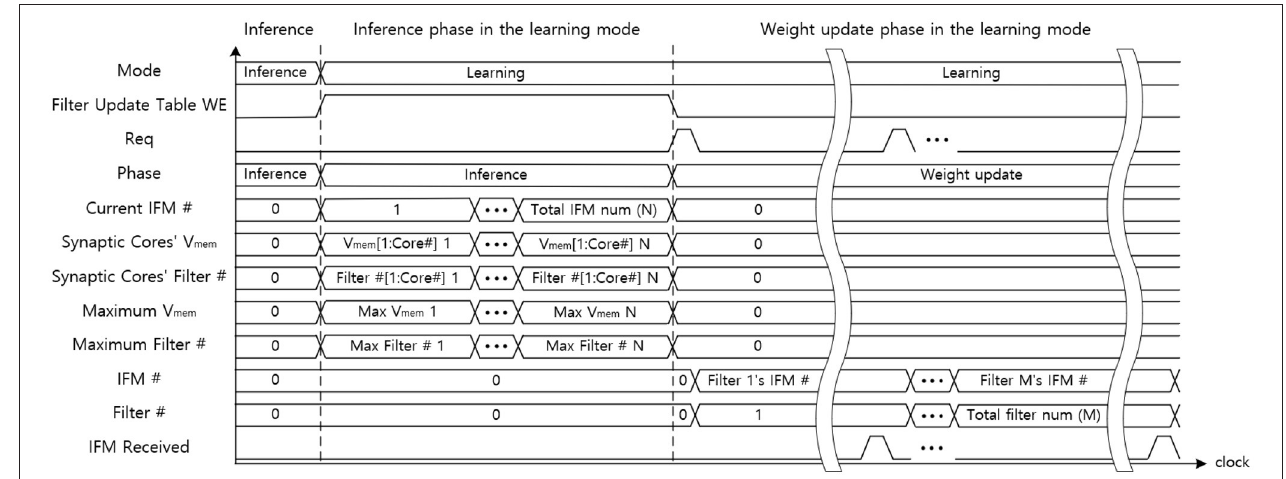
FIGURE 14 | The data flow graph of the central STDP